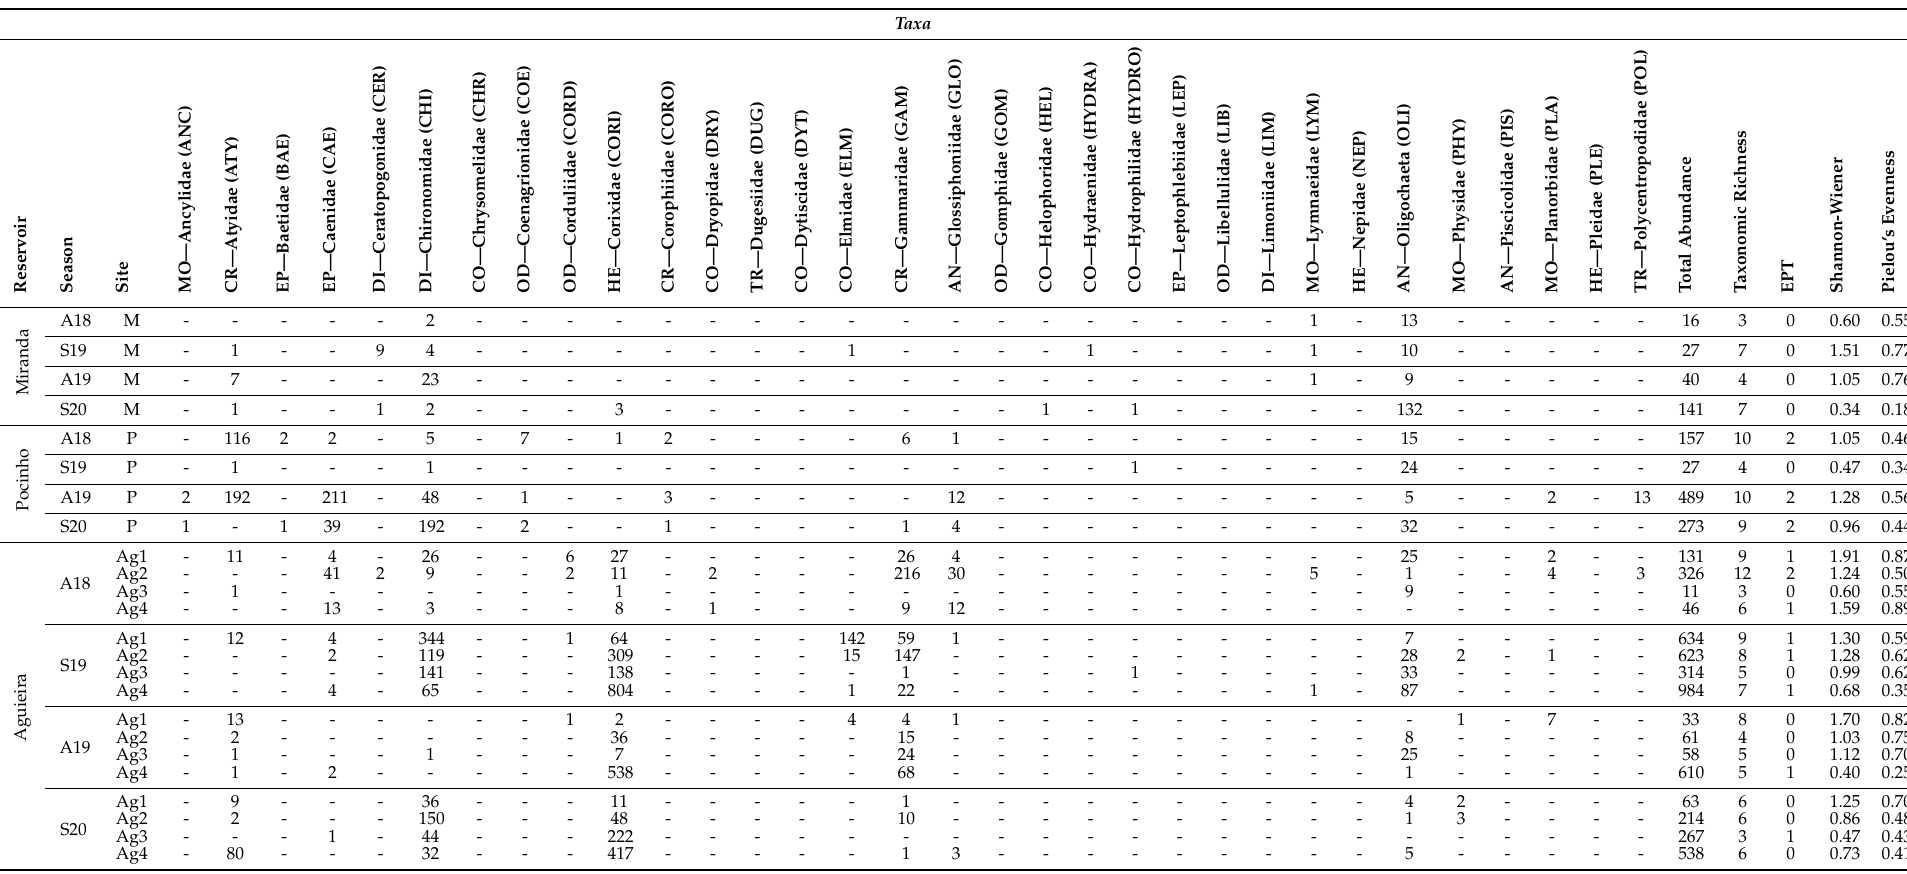
Table 2. Abundances of macroinvertebrates (number per sampling effort) in each site of Miranda, Pocinho, Aguieira and Alqueva reservoirs. EP—Ephemeroptera; TR—Trichoptera; DI—Diptera; HE—Heteroptera; MO—Mollusca; AN—Annelida; CR—Crustacea; CO—Coleoptera; OD—Odonata; EPT stands for Ephemeroptera, Plecoptera and